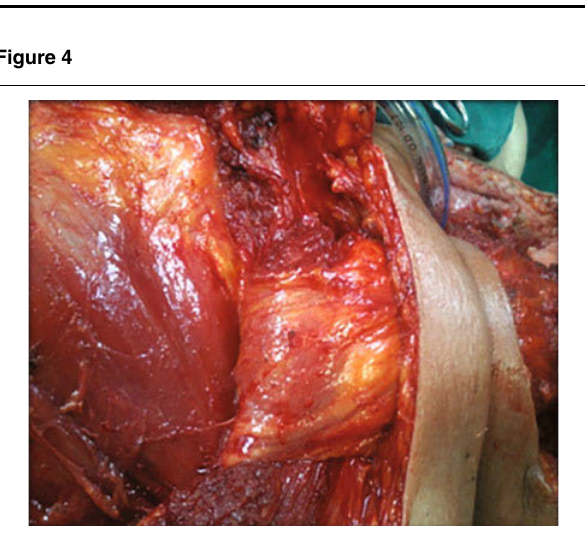
Pectoralis muscle turned in the neck.